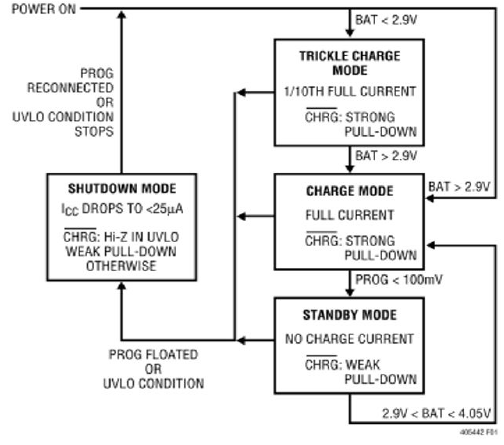
Figure A4. State diagram of a typical charge cycle.